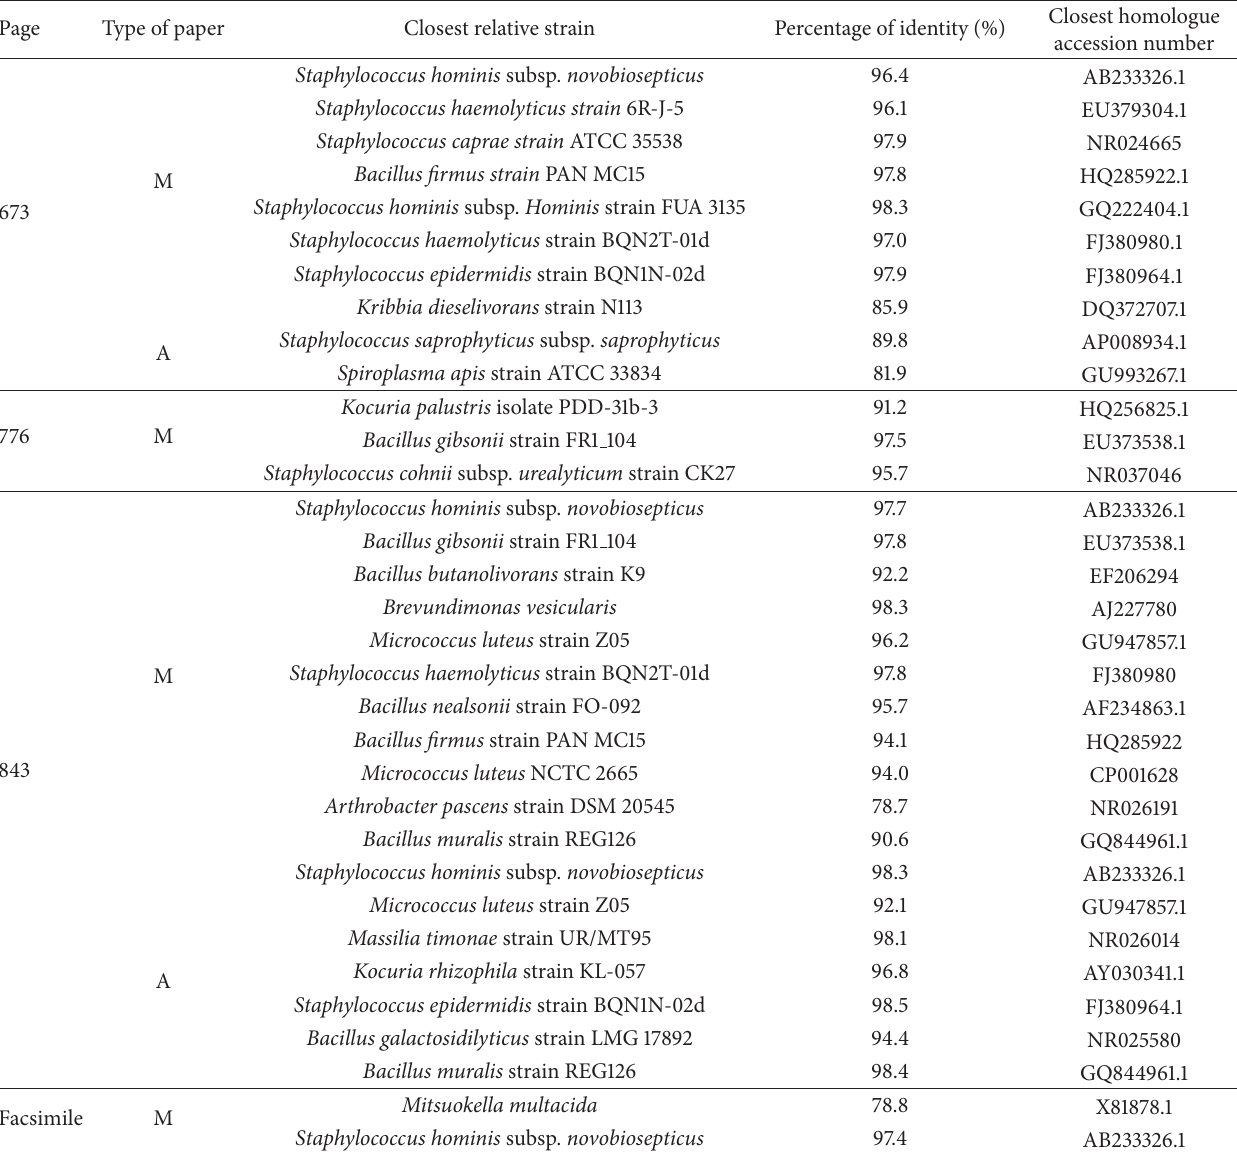
Table 2: 16S rDNA-based identification of bacterial isolates. M: modern paper, A: antique